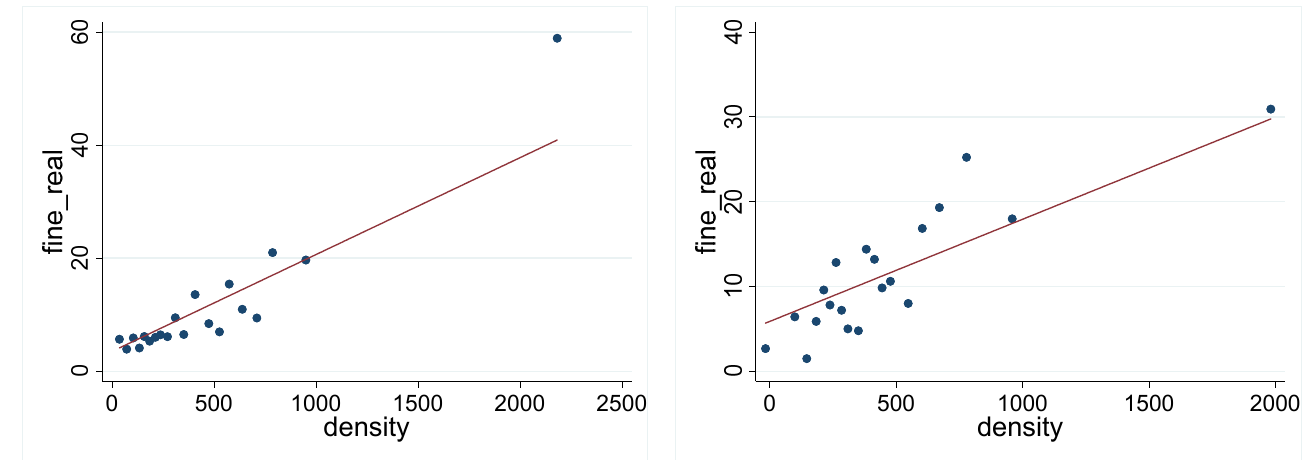
Figure 5. The relationship between population density and the total value of financial penalties issued by regulators to banks 6 .